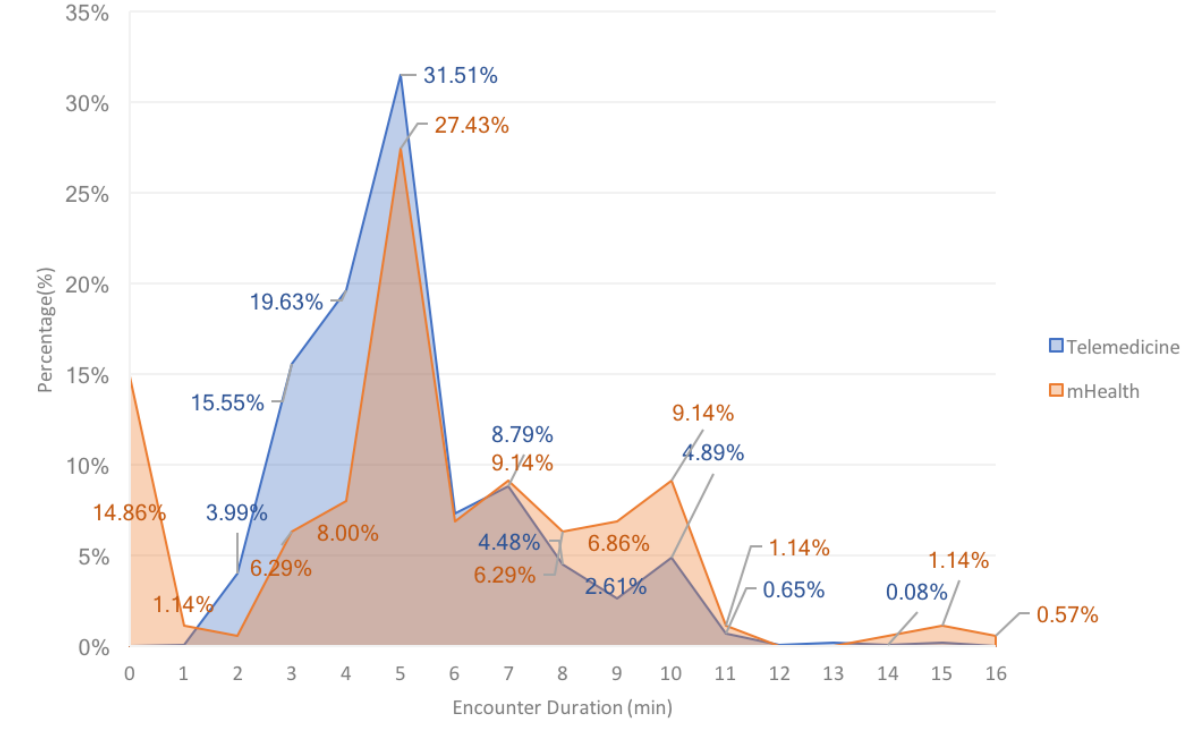
Figure 1. Distribution of encounter durations by encounter methods.